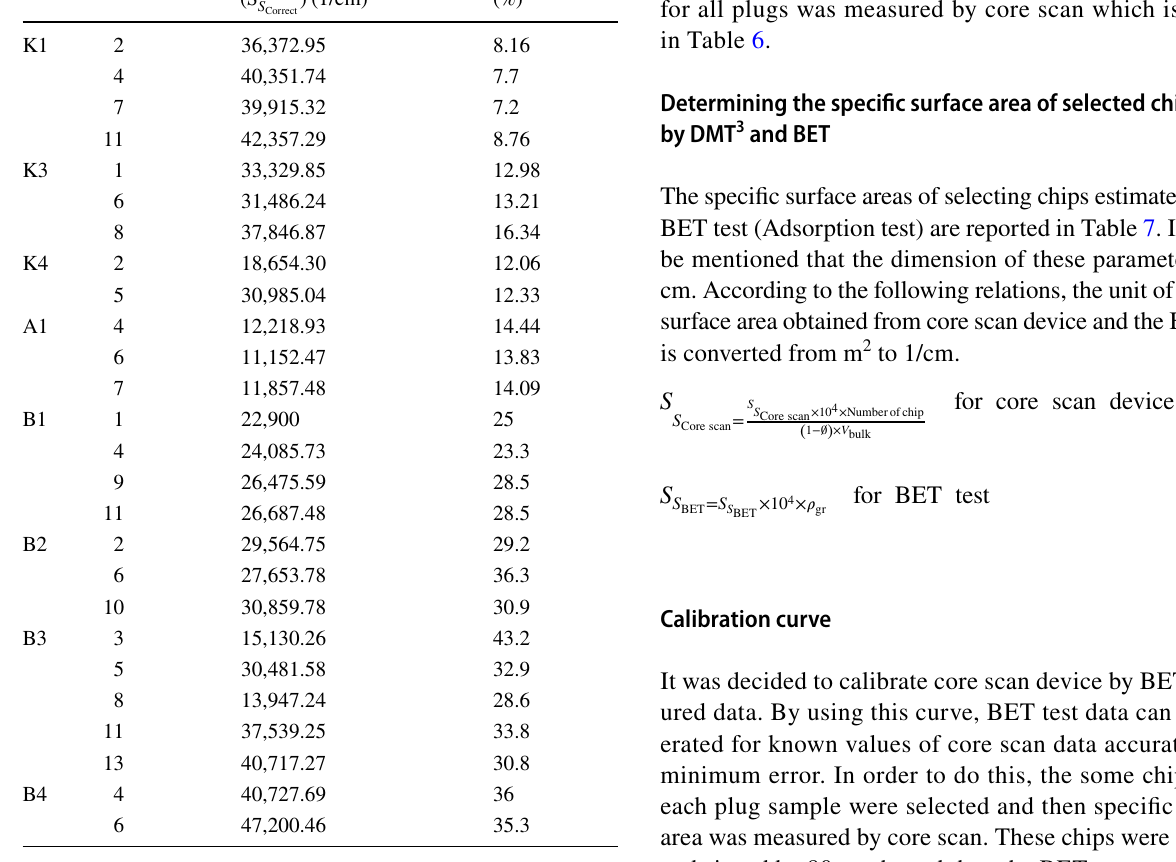
Porosity of selected chips